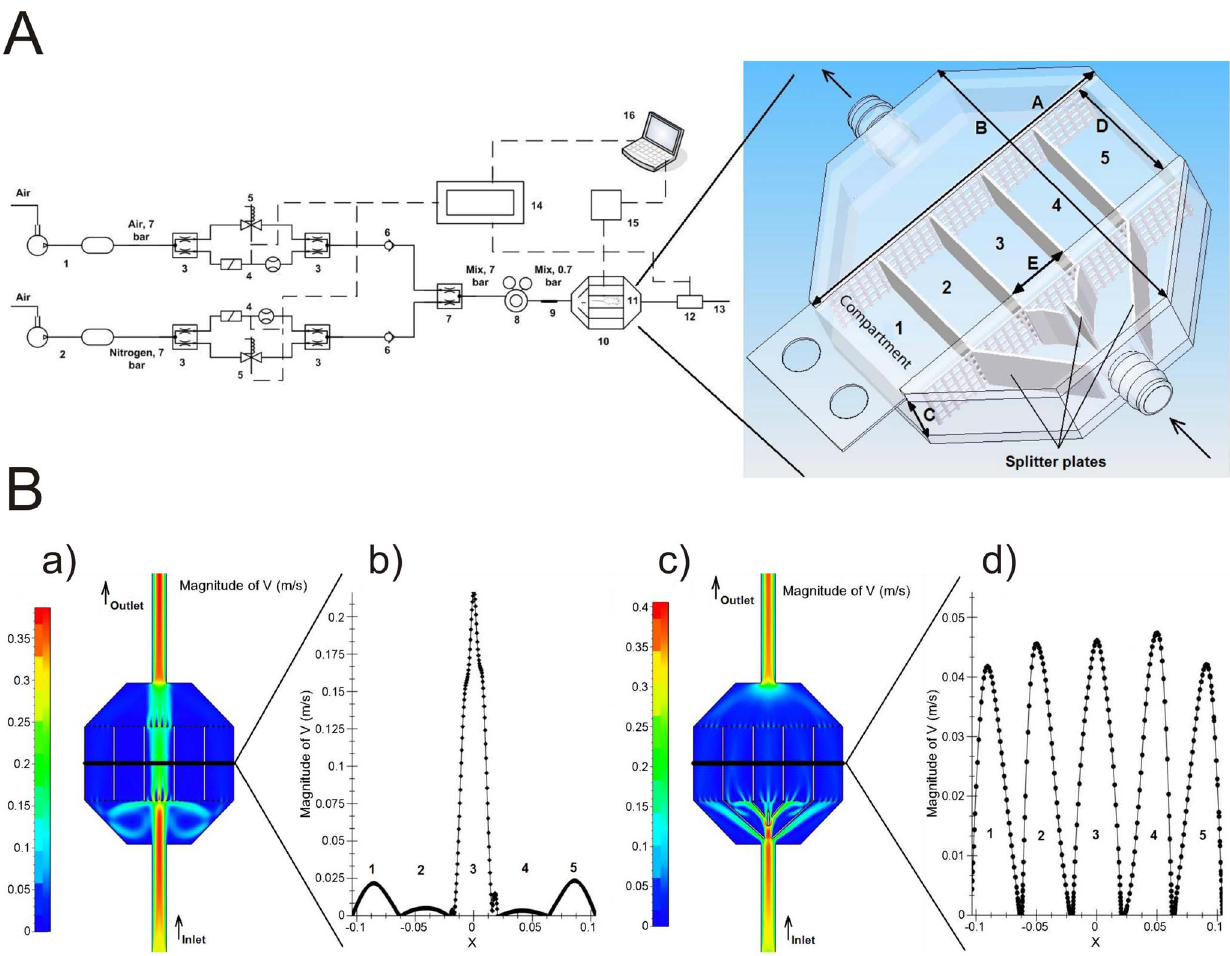
Figure 1. A device providing reliable and homogenous gas concentrations in individual mouse rooms . A: Technical scheme of the circuitry 1) air compressor and tank, 2) nitrogen compressor and tank, 3) T-connectors, 4) flowmeter with an analogue valve, 5) solenoid valve, 6) check valve, 7) Y-connectors, 8) pressure regulator, 9) static mixer, 10) mouse cage, 11) mouse, 12) oxygen sensor, 13) outlet of gas mixes, 14) controller with touch panel, 15) device to measure arterial blood oxygen saturation, 16) notebook to control, visualize and save the data. Solid line: pipes, dashed line: electrical wires. B: Insertion of splitters in the airflow allows gas concentrations to be homogenised within the mouse chambers: CFD simulation of the gas flow in the mouse box without (a) and with (c) splitters; velocity profiles inside each box without (b) and with (d) splitters (section cut).